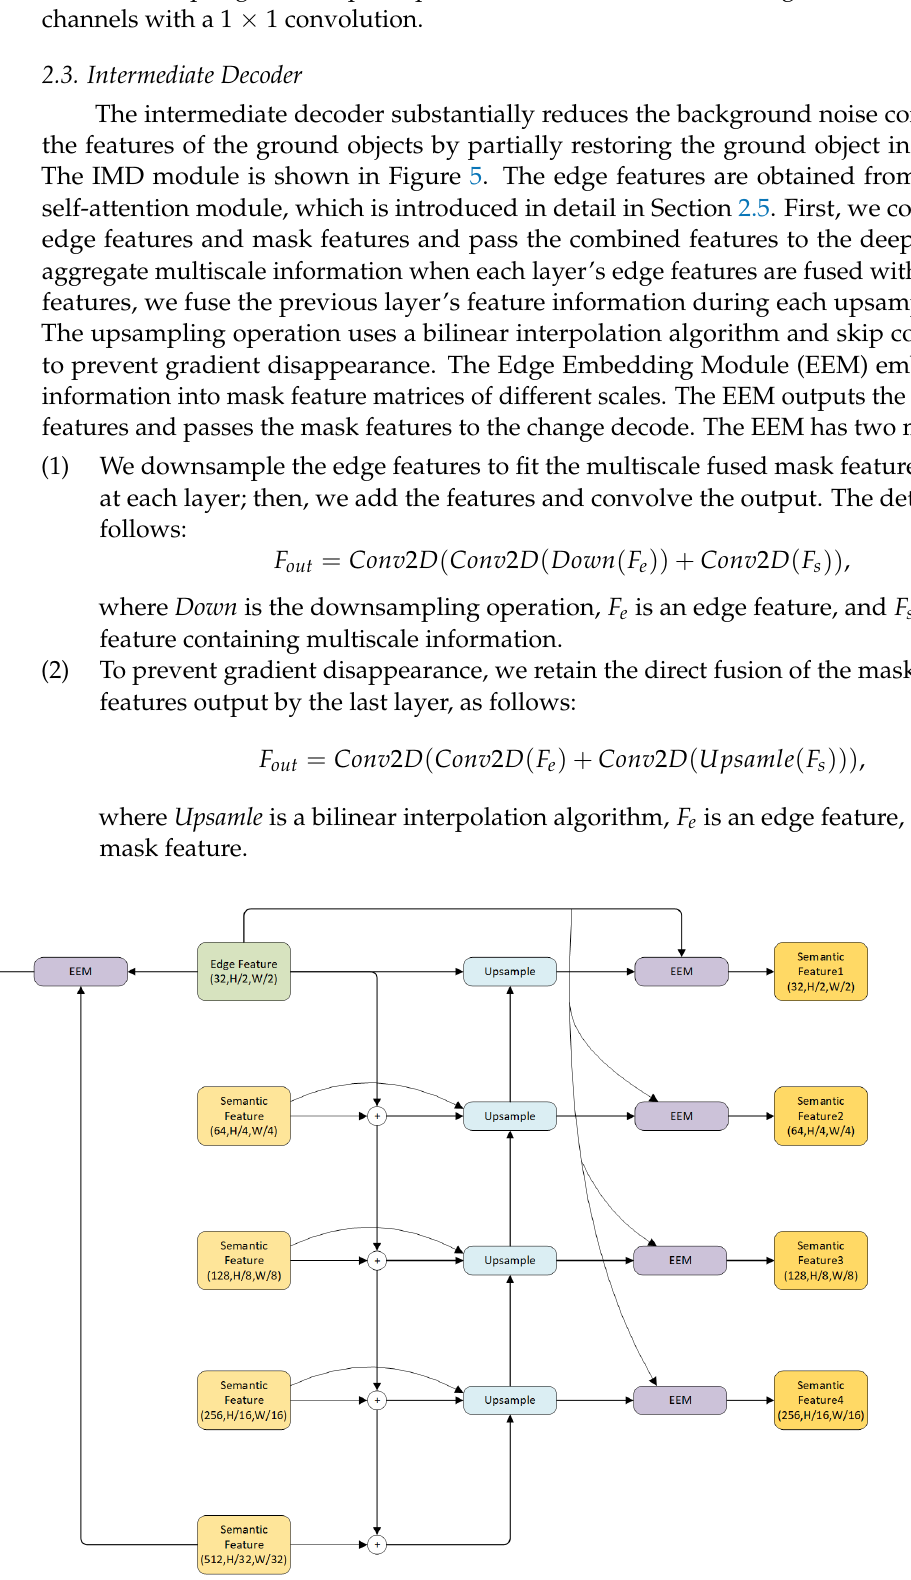
Figure 5. The details of the IMD. EEM represents the edge embedding module.